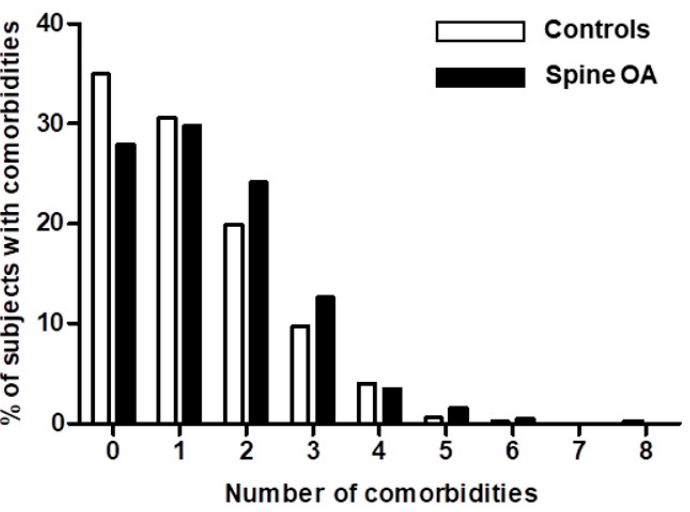
Figure 1. Distribution of proportion of controls and subjects with spine OA according to the number of comorbidities. Abbreviation: OA, osteoarthritis.